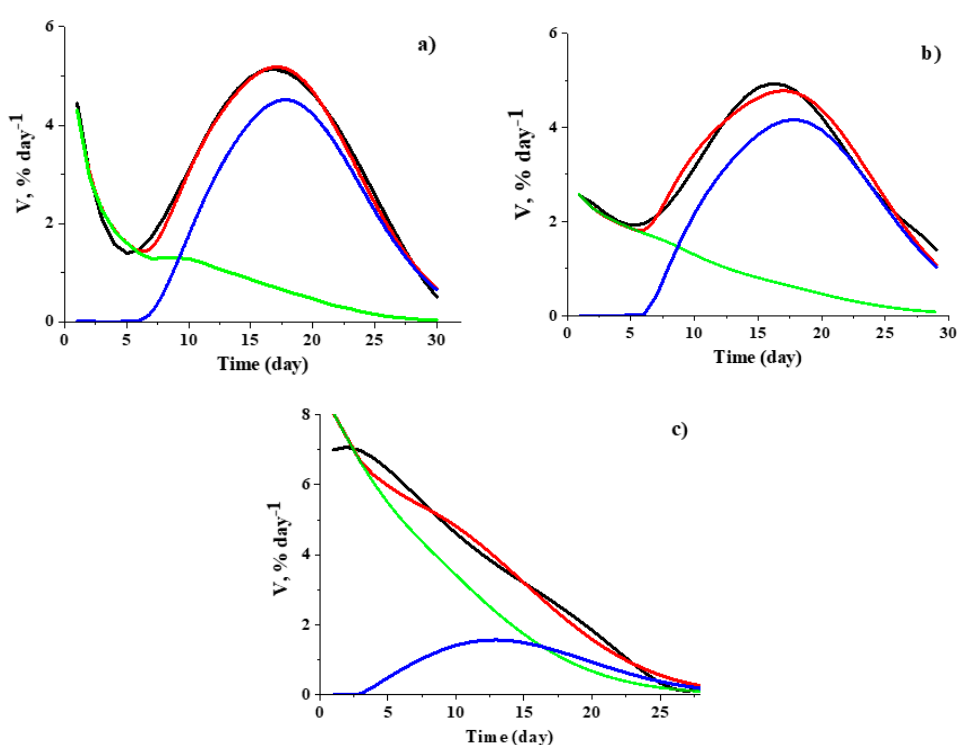
Figure 14. Experimental differential curves (black lines) and corresponding numerical modeling of TEMPOL ( a ) and ATI ( b ) release from 200 μ m films and of TEMPOL ( c ) release from 50 μ m film: the red lines are the results of modeling, and green and blue lines are contributions of the dopant release through the pores formed at the first and the second stages of pore formation, respectively (see text).